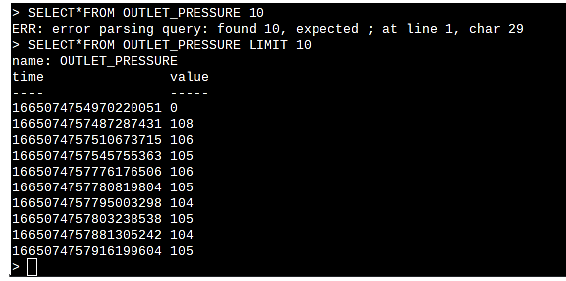
Figure 14. Verification of database functionality.